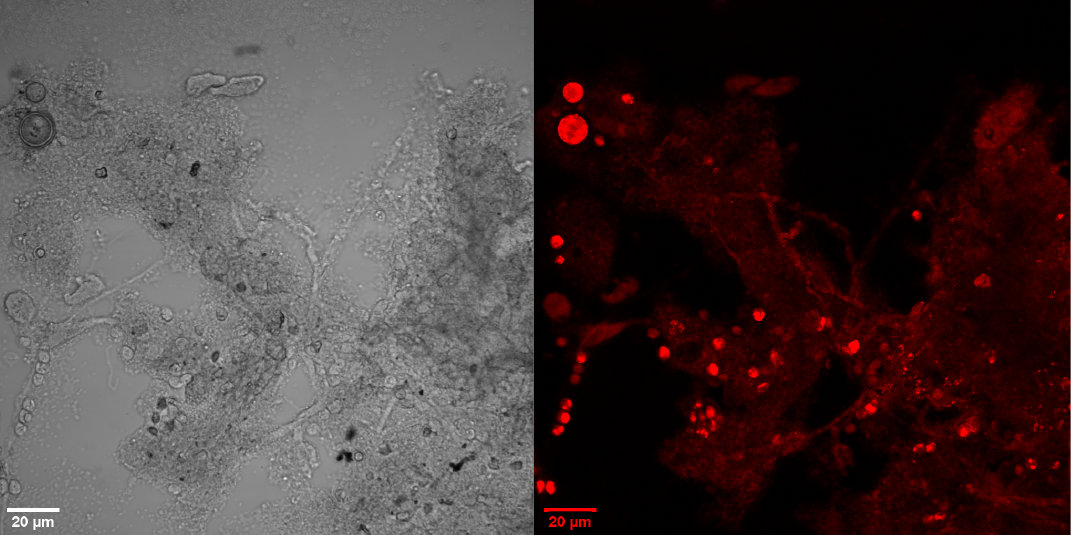
Figure 12. Microscopic images (objective 60×) of the sample (batch reactor) observed in visible light and after using Nile Blue A procedure with red filter and blue laser excitation. The photo was taken on day 66 of batch process. Table 2. Continuous-flow reactor measurements between day 53 and day 57.